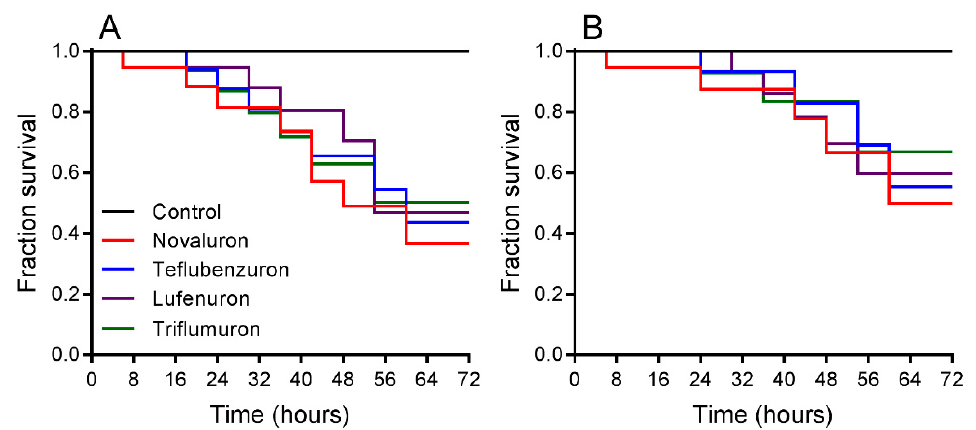
Figure 1. Survival curves of Leptopharsa gibbicarina nymphs exposed to four BPUs, estimated using the Kaplan–Meier log–rank test. Lethal concentrations: ( A ) LC 50 ( χ 2 = 15.53, p < 0.0001) and ( B ) LC 25 ( χ 2 = 8.94, p < 0.0012).